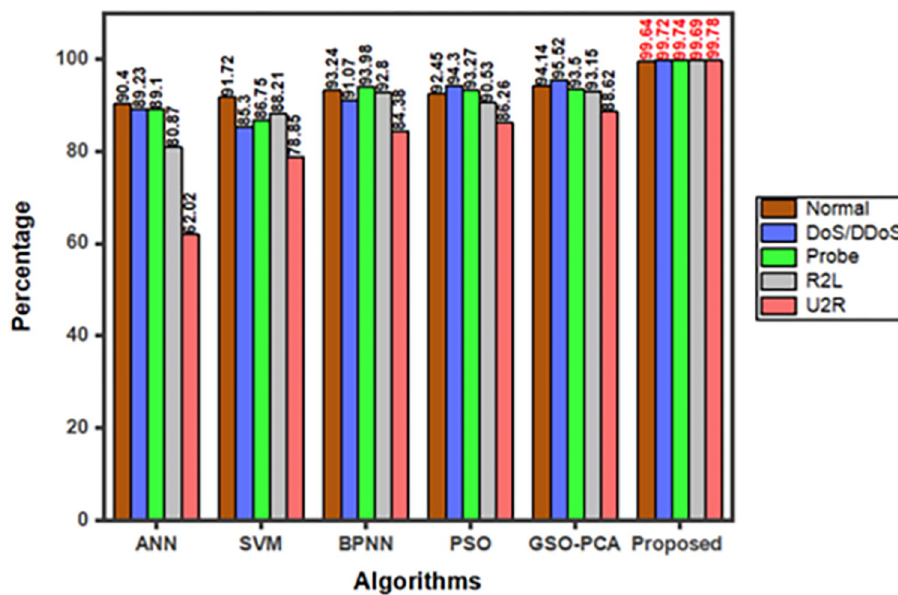
Fig 9. Accuracy comparison for individual cyber attack with various